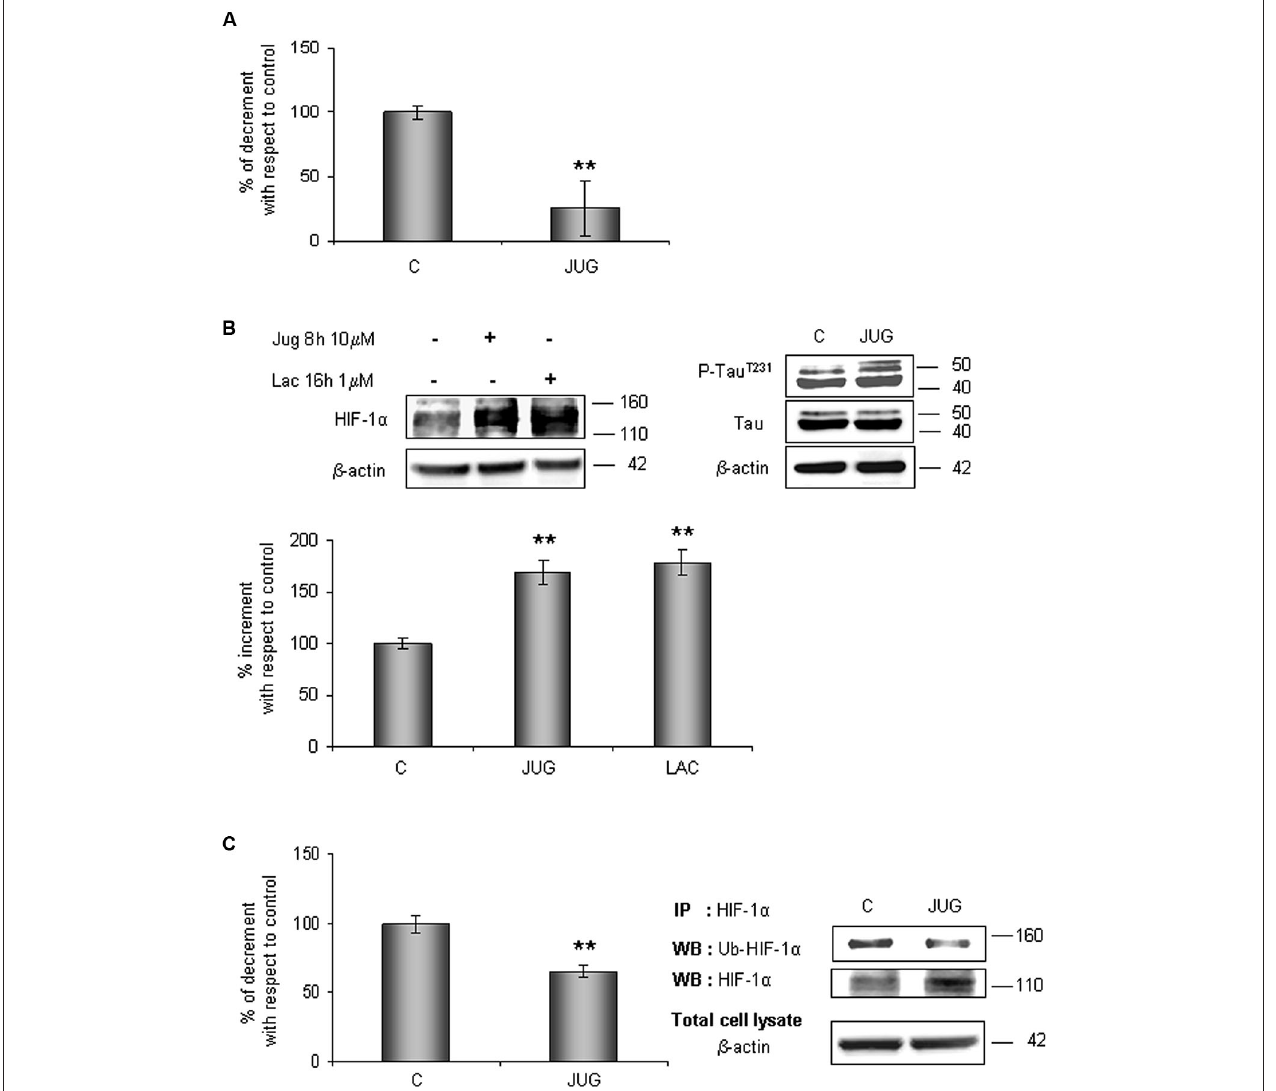
results obtained are shown on the bar-graphs. Anti- β -actin antibody was employed to confirm equal protein loading in the different lanes, normalization was carried out with respect to the β -actin amount in the same sample. (C) HIF-1 α ubiquitination state decreases after juglone treatment. Western blot analysis showed a 110 kDa and 140 kDa bands corresponding to HIF-1 α and to ubiquitinated HIF-1 α protein respectively. Proteins were detected by specific antibodies (anti-HIF-1 α ; anti-ubiquitin), revealed by ECL and semi-quantitatively determined by a KODAK image station 2000R. Results obtained are shown on the bar-graphs. IP, immunoprecipitation; WB, western blot. Data represent the mean ± SEM of 3 separate experiments performed in triplicate. Statistical significance is obtained with Student’s t -test in comparison with controls. * p < 0.05, ** p <